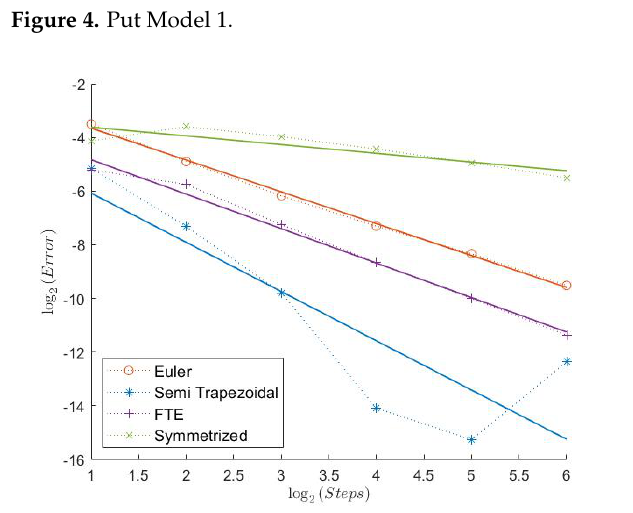
Figure 4. Put Model 1.